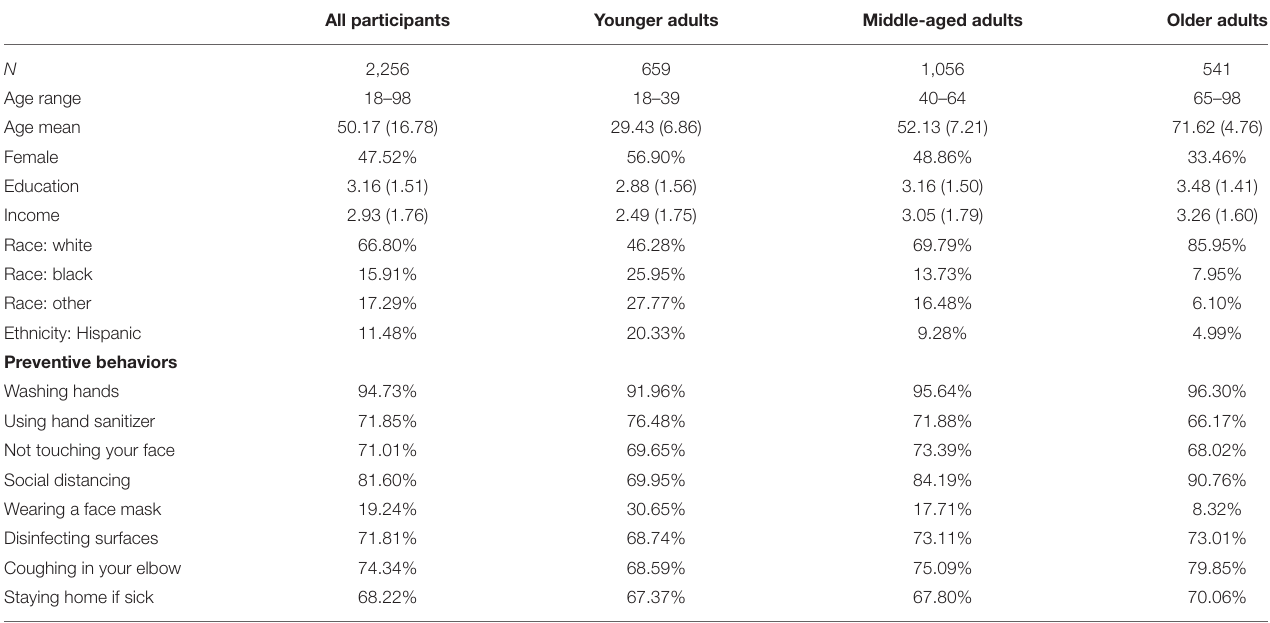
TABLE 1 | Descriptive statistics for full sample and by age category.